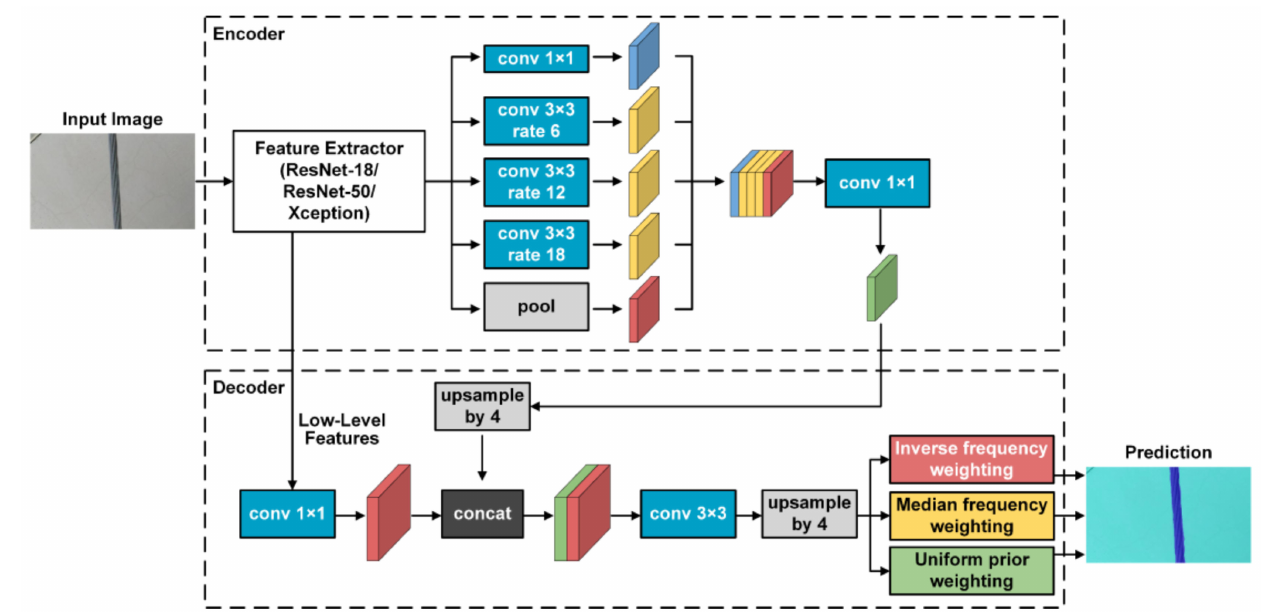
Figure 7. Detailed structure of the underlying framework of modified CNN frameworks.